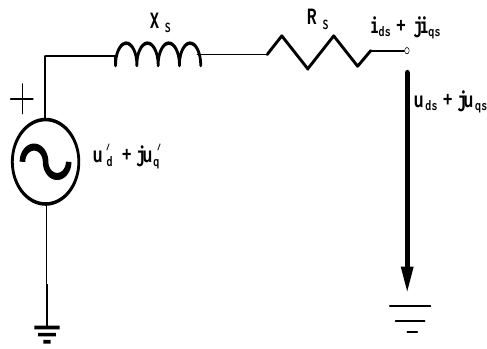
Figure 3. Induction generator transient model.